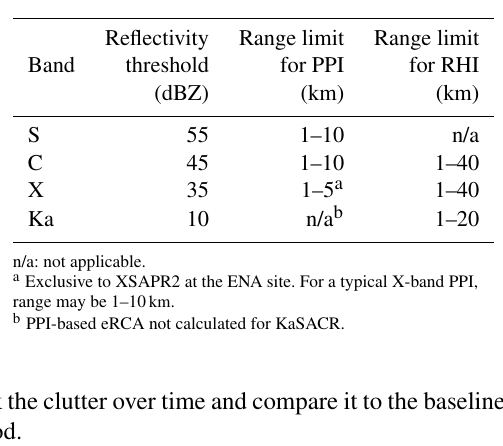
Table 2. Thresholds and ranges for different radar frequencies for generation of the composite clutter